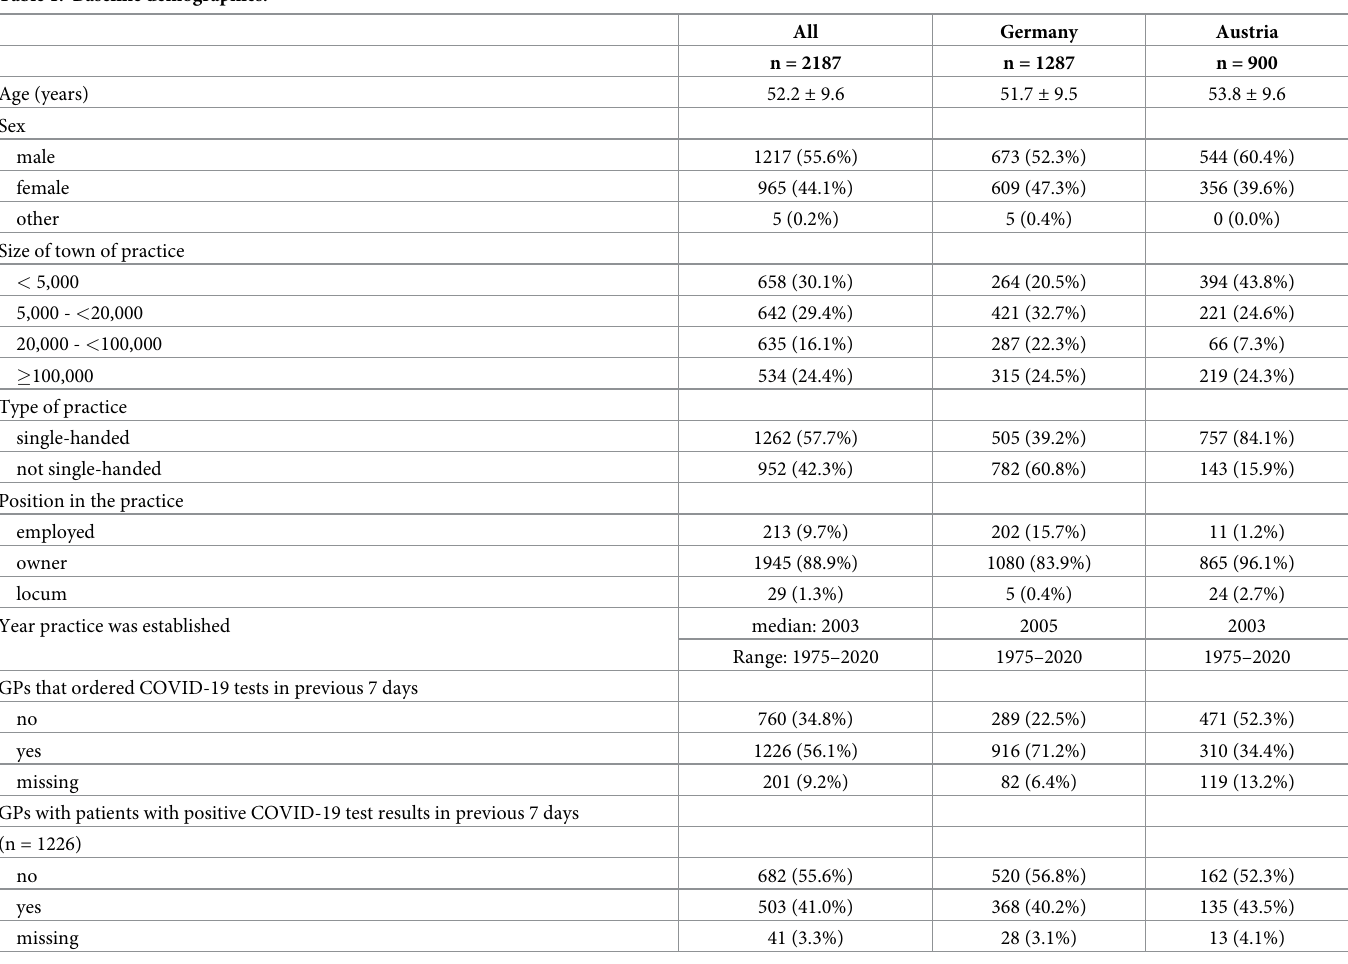
Table 1. Baseline